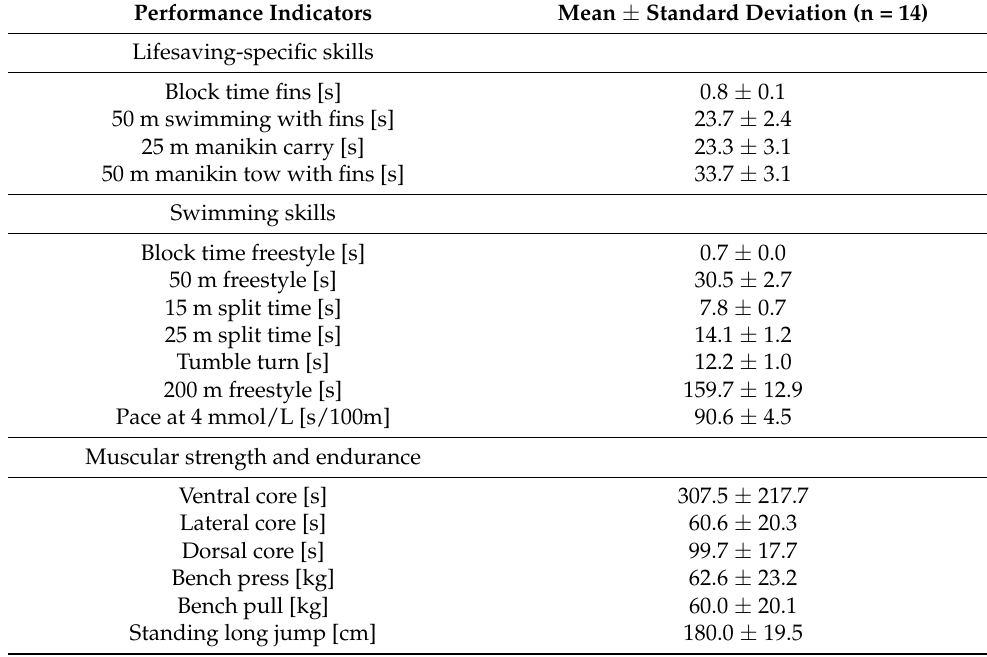
Table 1. Descriptive data for the performance